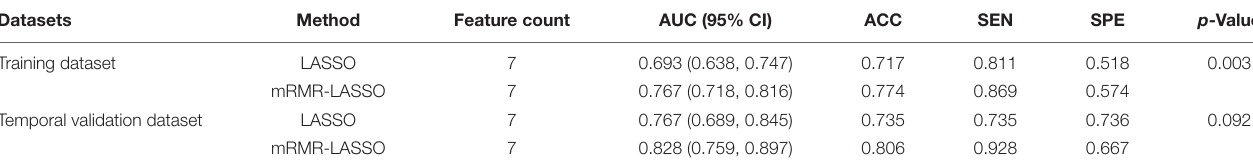
TABLE 3 | Performance of the “LASSO model” and “mRMR-LASSO model.”